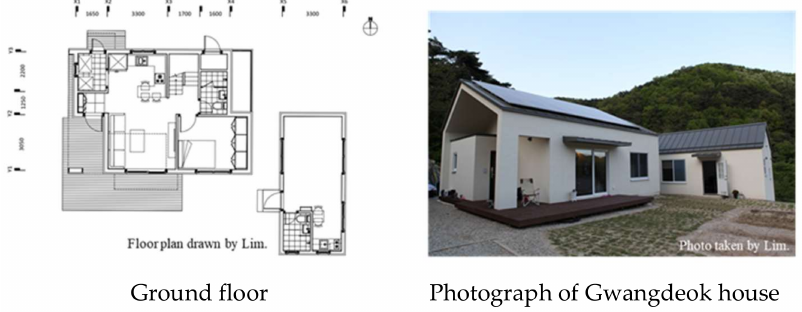
Figure 2. Floor plan and south view of Gwangdeok